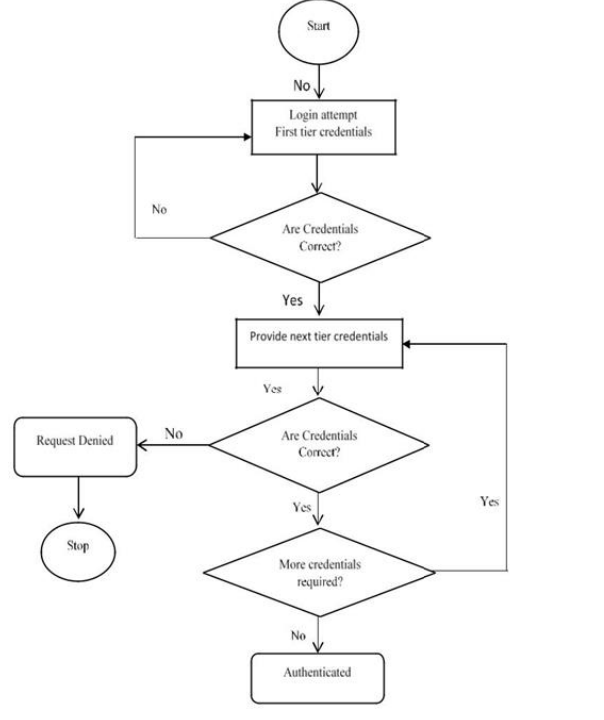
Fig. 1 work flow of